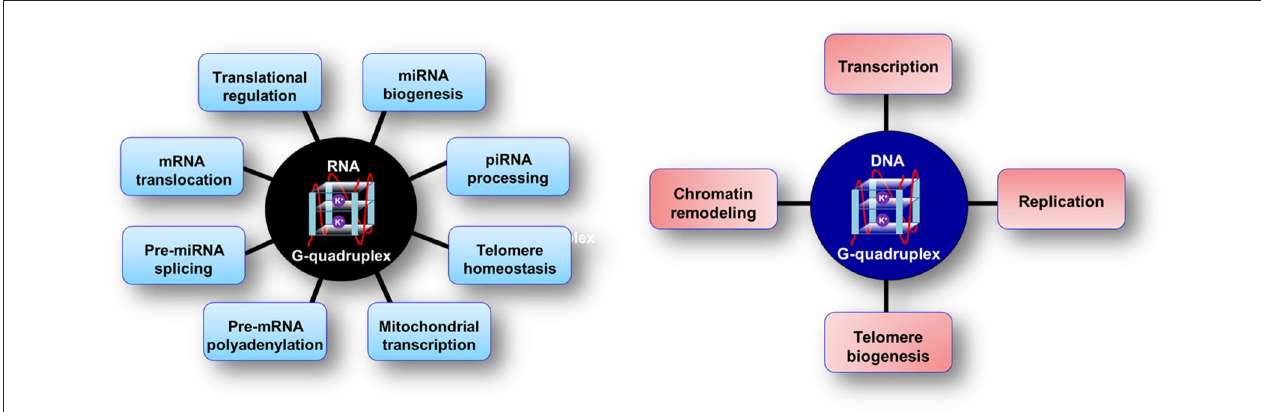
FIGURE 1 | Cellular processes influenced and modulated by RNA and DNA G-quadruplex